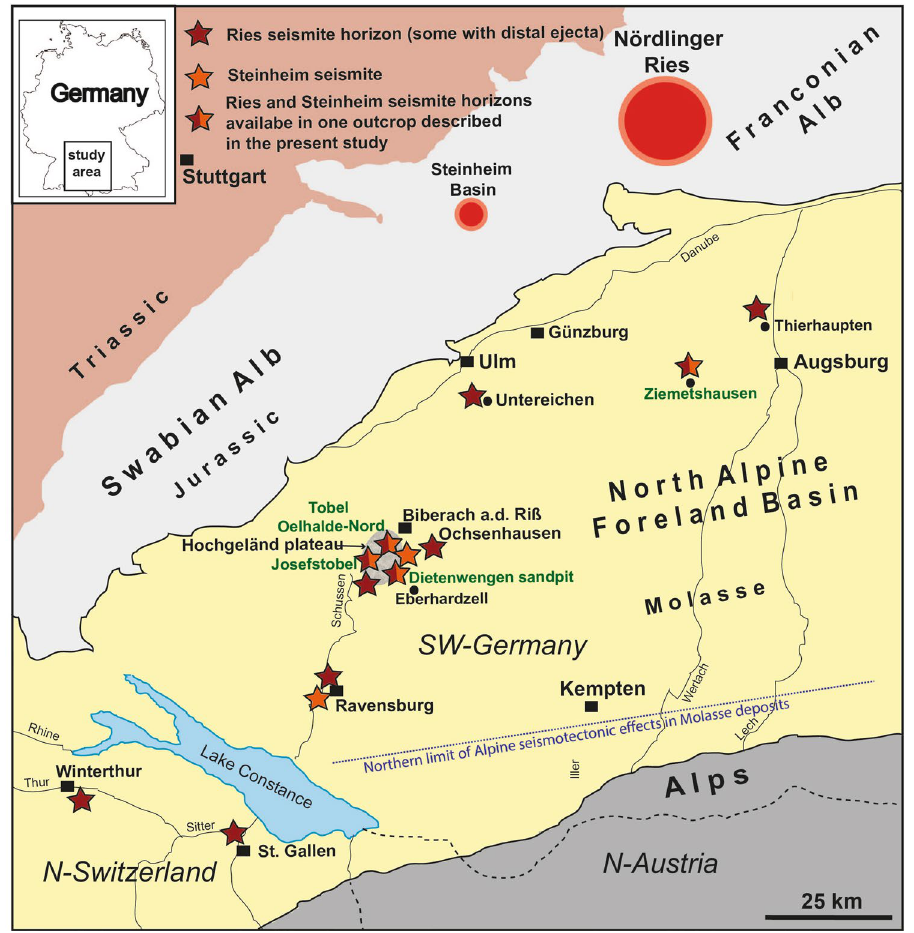
Figure 1. Geographic and geologic situation in the study area in southern Germany, northern Switzerland and Austria. Marked by red stars are outcrops of the Ries seismite within a distance of up to 205 km from the Ries crater, and the proposed Steinheim seismite (orange stars) within a distance of up to 100 km from the Steinheim crater. Four localties in green are presented and discussed in this study and are marked with stars half in red and orange. Note that no seismite occurences caused by Alpine seismotectonic events are known North of the dotted